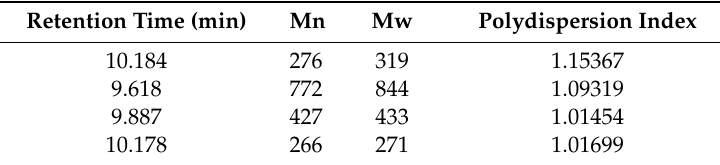
Figure 4. GPC chromatograms and calibration curves for ( a ) the hydrogenated rosin and ( b ) the XEHR. Table 3. GPC data for the hydrogenated rosin and